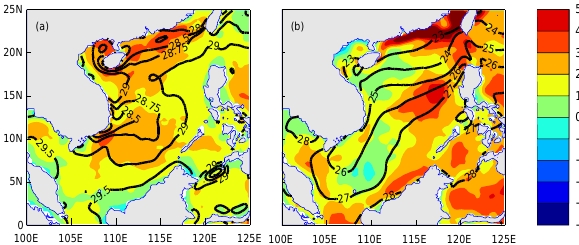
Figure 1. (a) Summer- and (b) winter-mean SST (contours; units: ◦ C) and SST trends (color shading; units: ◦ C 100yr − 1 ) in the SCS from 1982 to 2011.